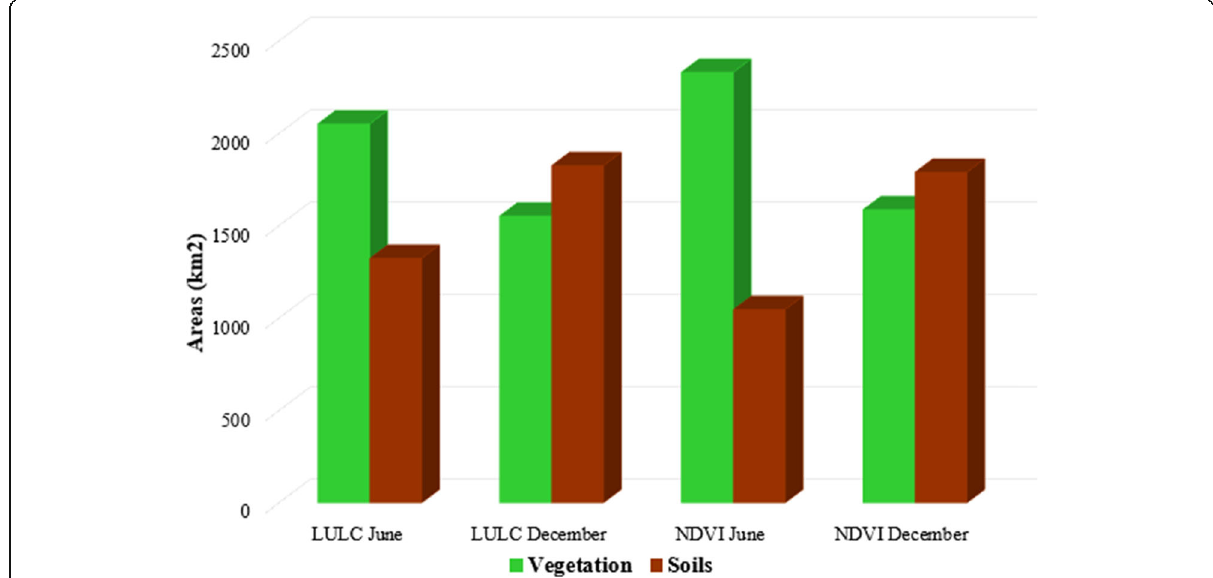
Fig. 15 Land Use Land Cover (LULC) – comparison for the classification and the NDVI